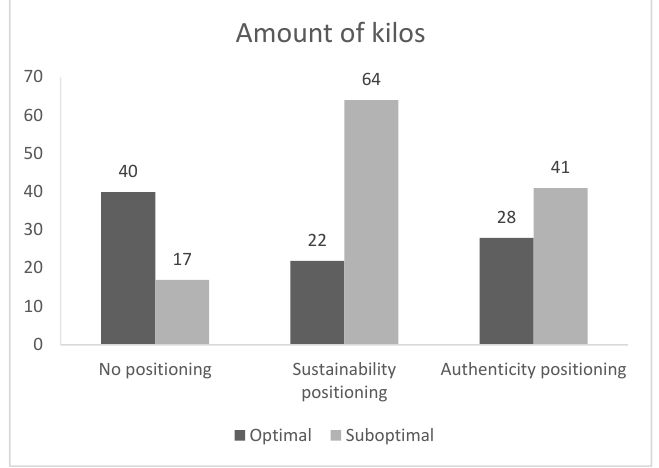
Figure 1. Suboptimal and Optimal Product Sales (in kg) in Study 1.